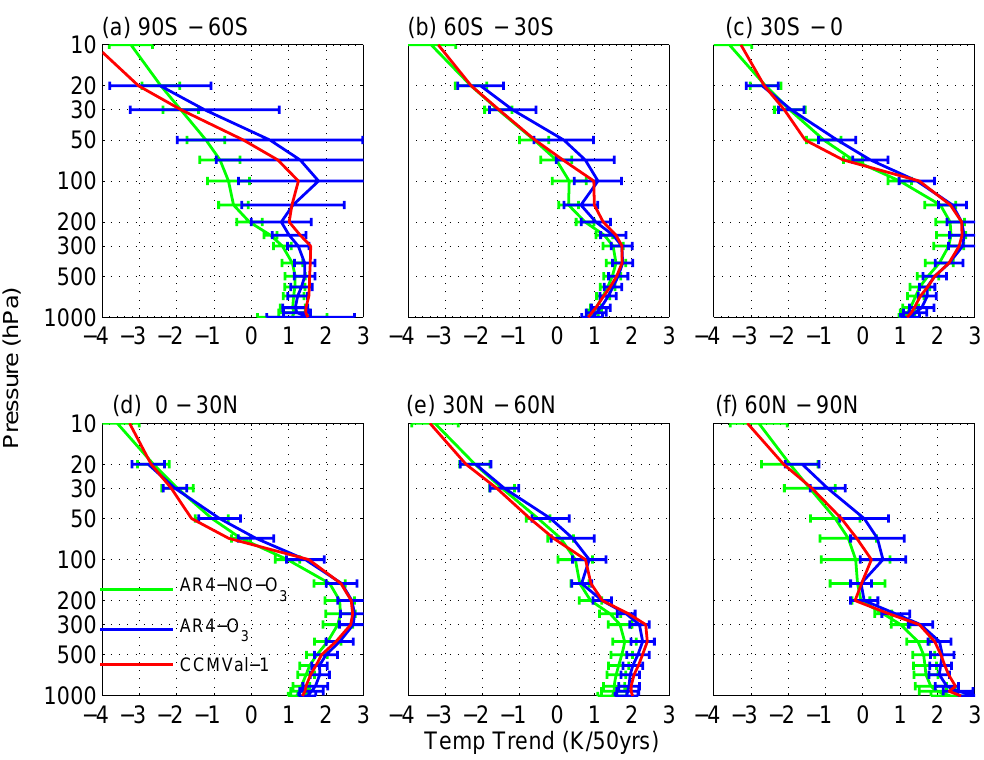
Fig. 3. Same as Fig. 2a, except for annual and regional mean temperature trends. (a) 90 ◦ S–60 ◦ S, (b) 60 ◦ S–30 ◦ S, (c) 30 ◦ S–0, (d) 0–30 ◦ N, (e) 30 ◦ N–60 ◦ N, and (f) 60 ◦ N–90 ◦ N.